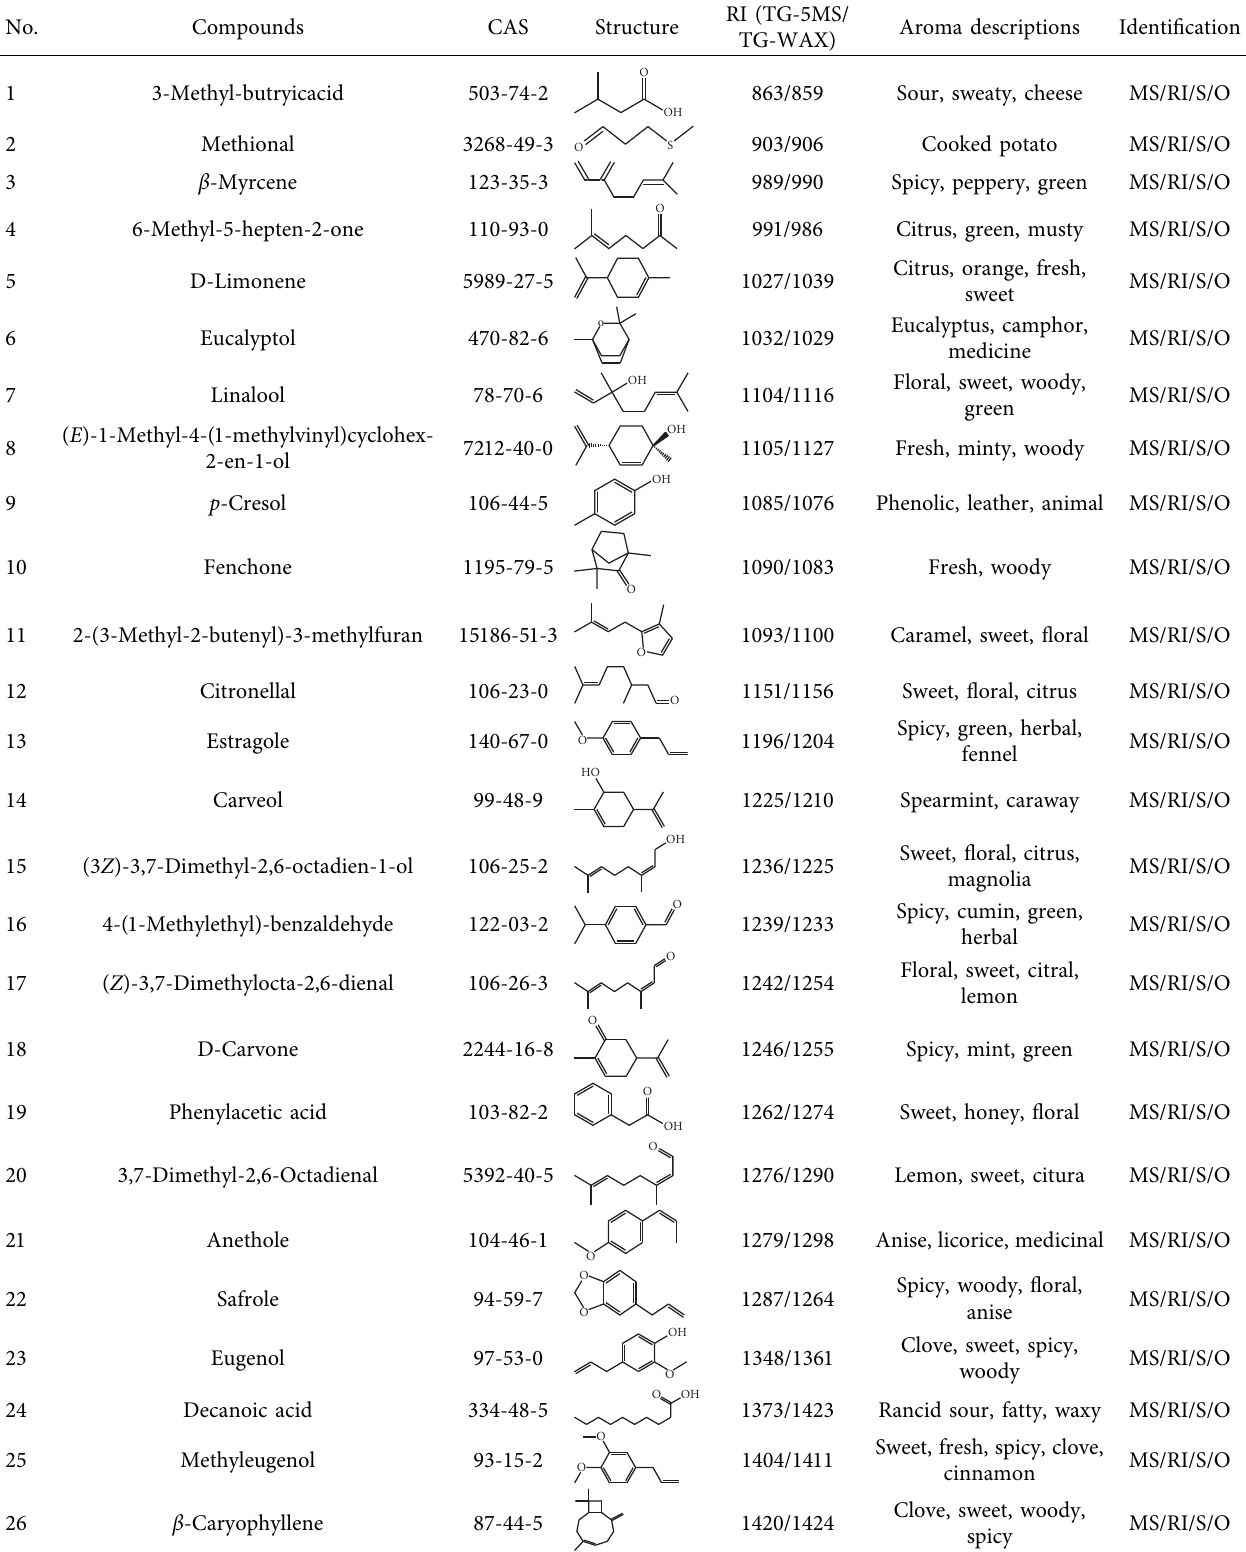
Table 3: Qualitative analysis results of aroma-active compounds (FD � 9) in Litsea pungens Hemsl. fruit.